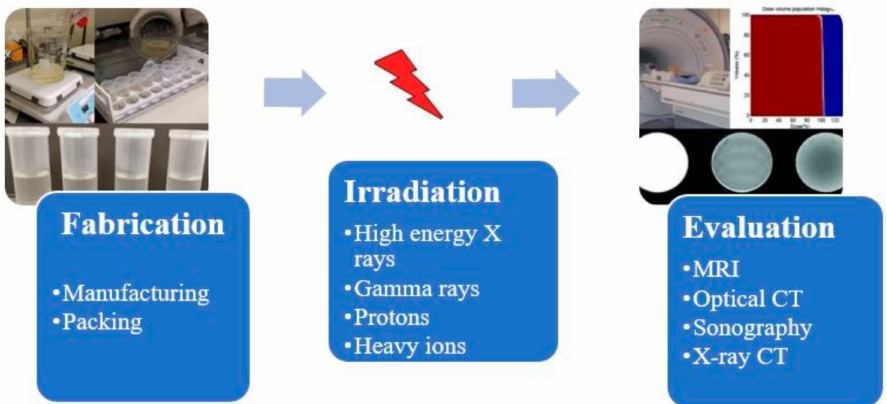
Figure 1. The process of obtaining dose distribution, using MAGIC-f. The figures were adapted from difference cited sources